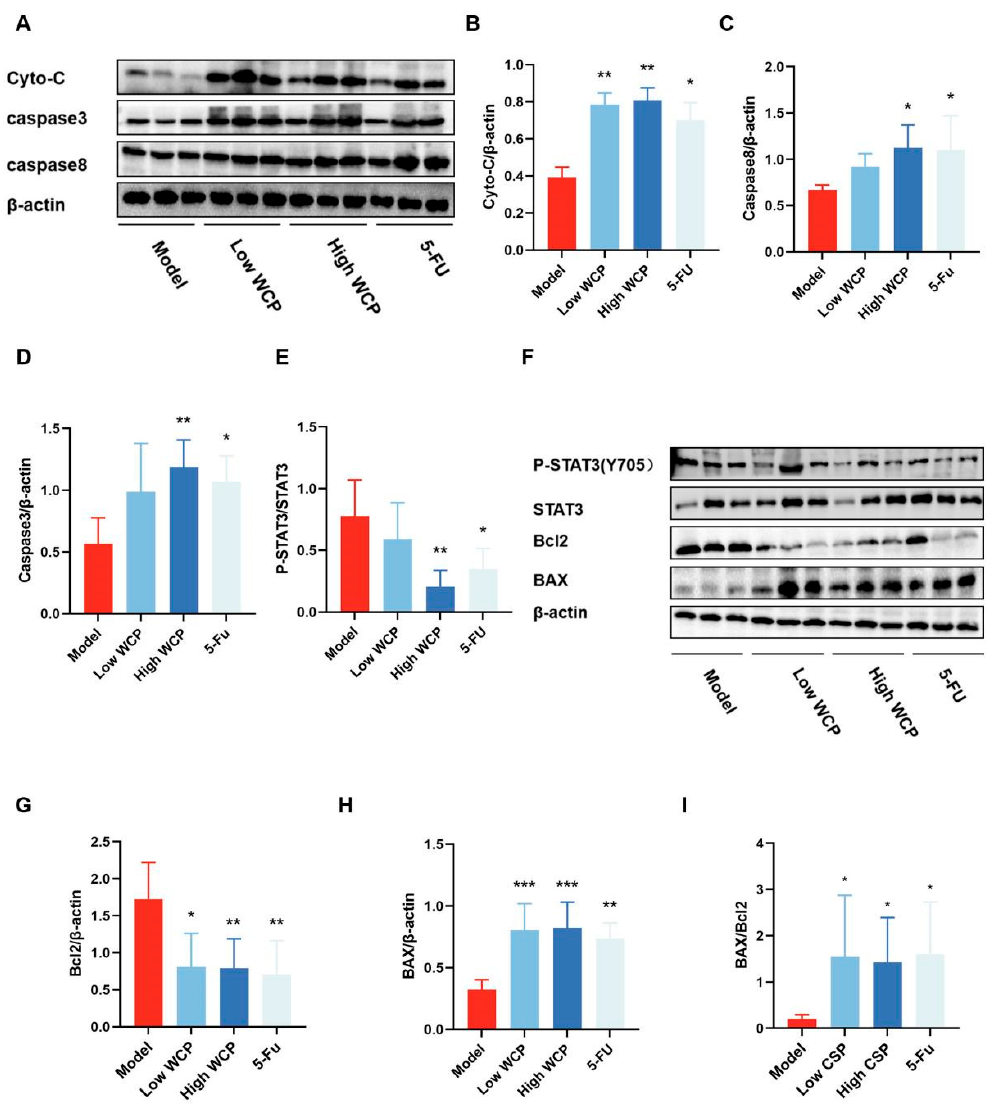
Figure 8. WCP promotes Cyto-c/Caspase8/3 and inhibits IL-10/STAT3/Bcl2pathway. ( A , F ) Photo- graphs of the proteins in each group. ( B – E , G – I ) Relative protein expression of Cyto-c, Caspase8, Caspase3, p-STAT3, Bcl2, Bax, and Bax/Bcl2. * p < 0.05, ** p < 0.01, *** p < 0.001 compared to model group.